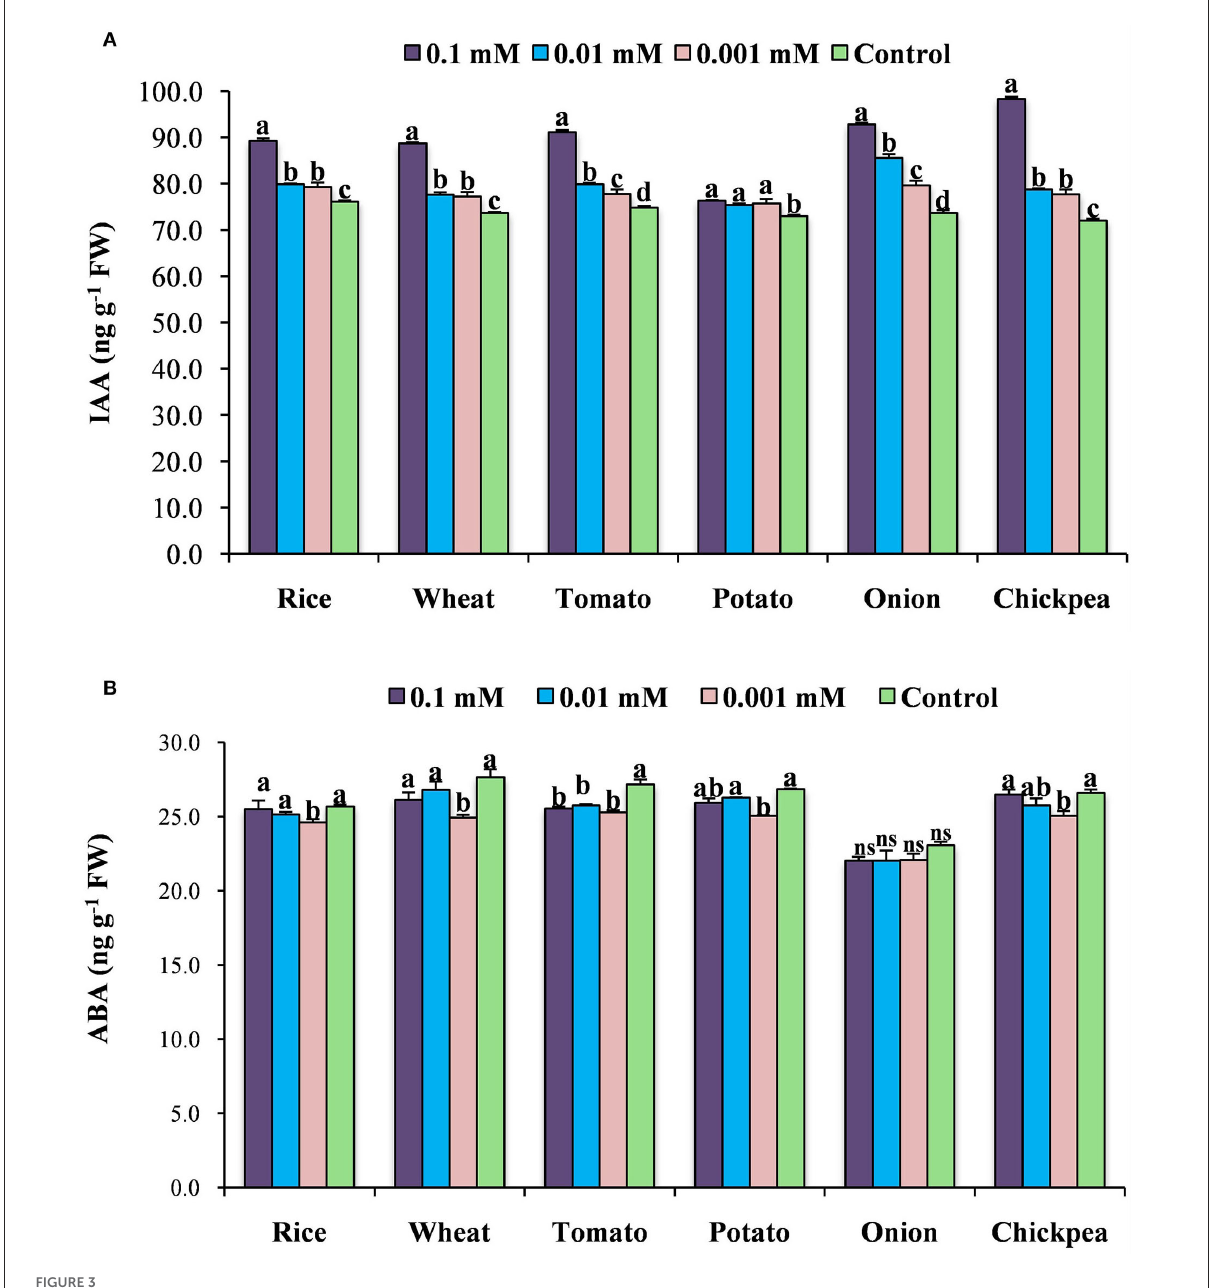
FIGURE3 Effect of calliterpenone on endogenous IAA content (A) and ABA content (B) in six crops. Statistical analysis was carried out taking means of three replicates; different letters above bars showed significant differences as compared to control (Duncan’s multiple range test P ≤ 0.05).